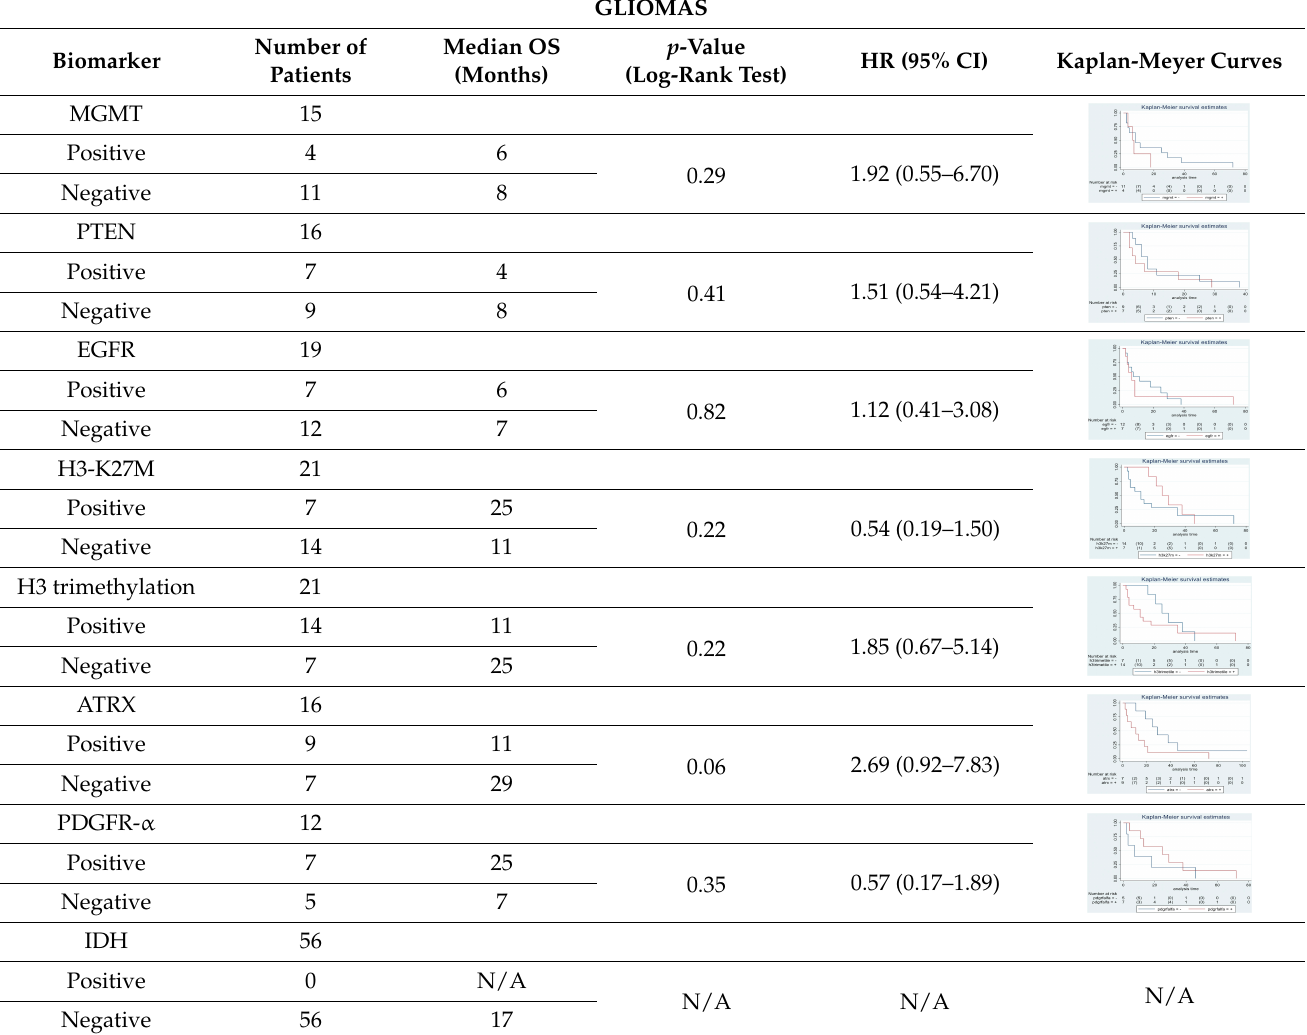
Abbreviations: CI, confidence interval; HR, hazard ratio; OS, overall survival.